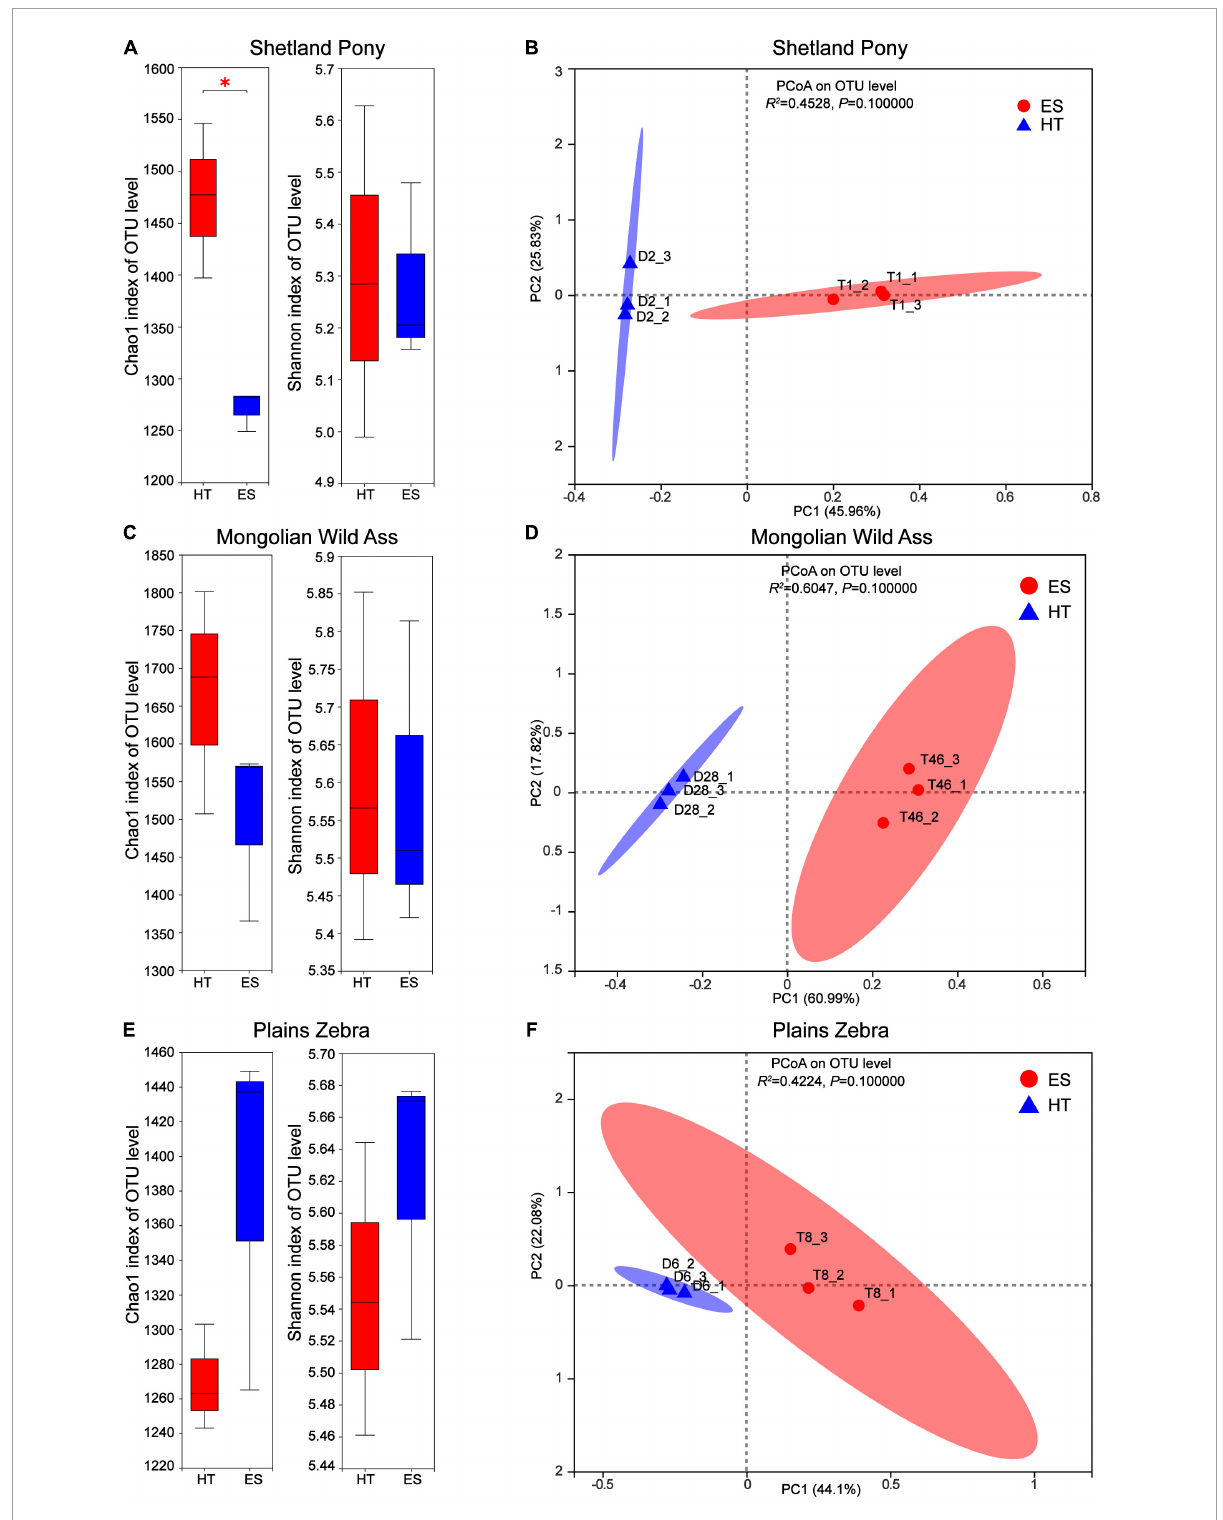
FIGURE2 Analysis of intestinal bacterial diversity and community composition of the same in different regions; (A,B) are Shetland Pony (SP) intestinal bacterial α -diversity analysis and β -diversity analysis, respectively; (C,D) are Mongolian Wild Ass (MA) intestinal bacterial α -diversity analysis and β -diversity analysis, respectively; (E,F) are Plain Zebra (PZ) intestinal bacterial α -diversity analysis and β -diversity analysis, respectively. * P <